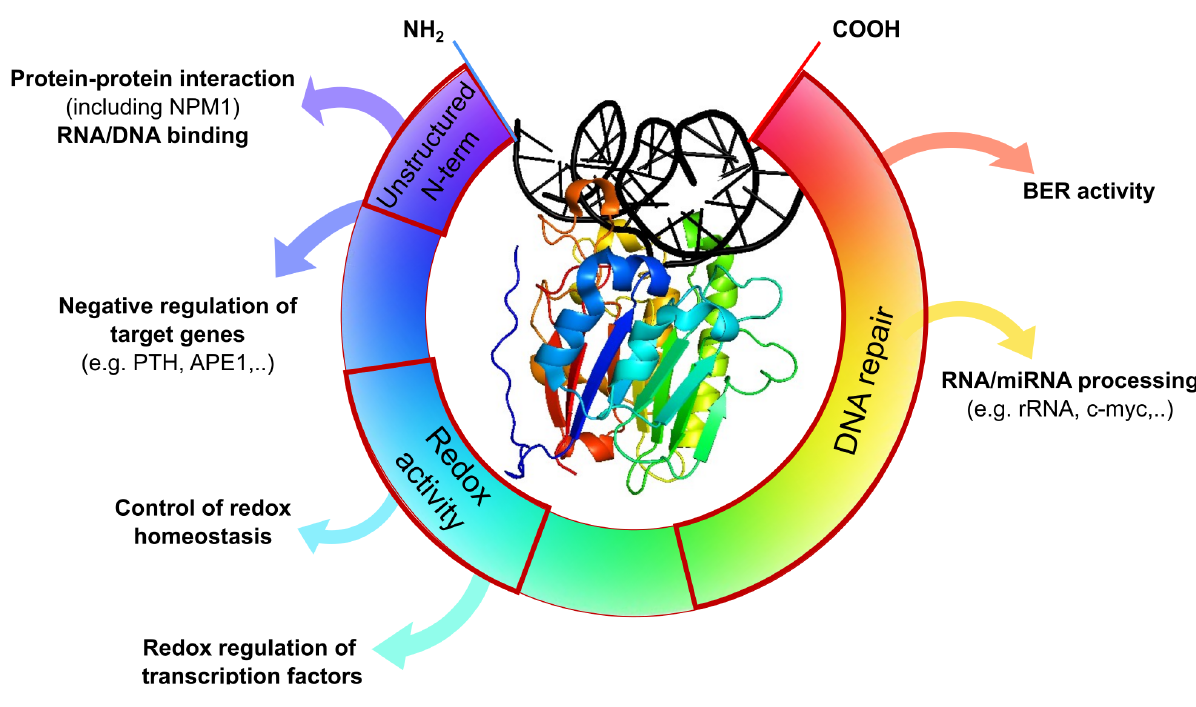
Figure 1: Main APE1 functions. The main functions of APE1 are mapped to the primary structure portions responsible for such effects [58,73,89]. The APE1 crystal structure bound to abasic DNA is displayed starting from the PDB deposited structure (6W0Q, [90]) and was modified using PyMOL software. Rainbow colors: APE1 sequence; black: substrate